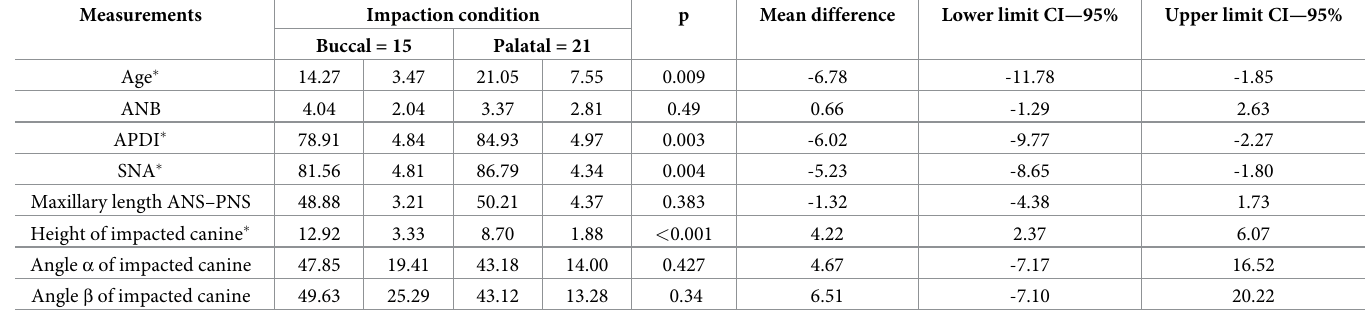
Table 3. Initial characteristics of the sample according to impaction condition of maxillary canine.